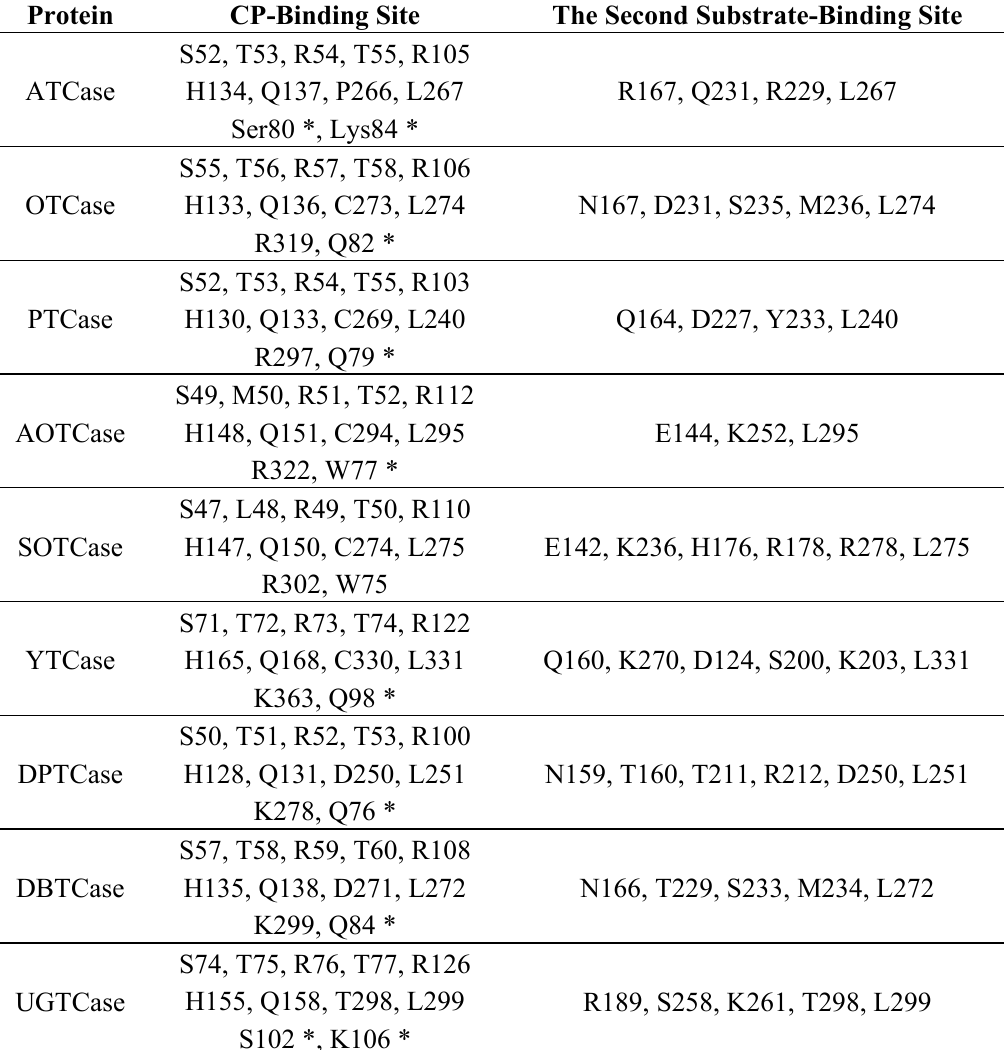
Table 1. Active site residues for various